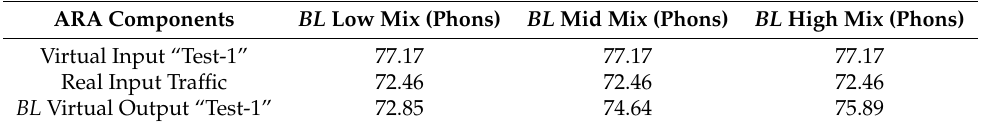
Table 5. BL ARA mix modes